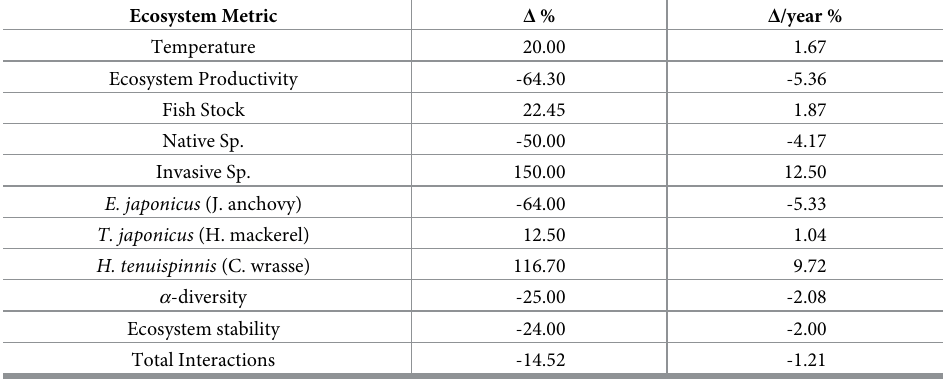
Table 1. Observed changes in ecosystem community and population metrics. Metrics are evaluated considering 2002 and 2014 observed values. Negative Δ % are for decrease in values over time. Δ /year % are the yearly changes over 12 years. Ecosystem stability is based on the real part of the dominant eigenvalue of the whole community (S12A